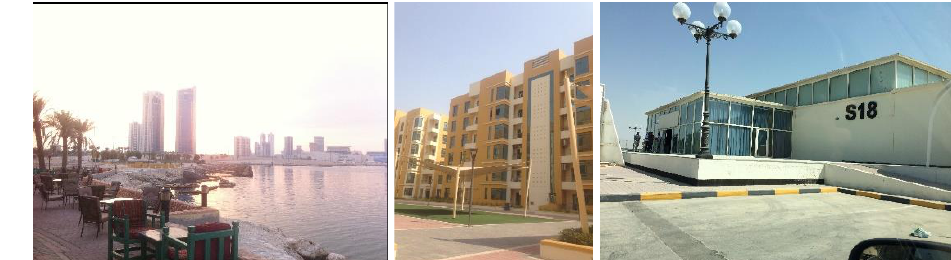
Figure 12: Different type of new Buildings in Bahrain are not related to social rotes leads to lose the identity